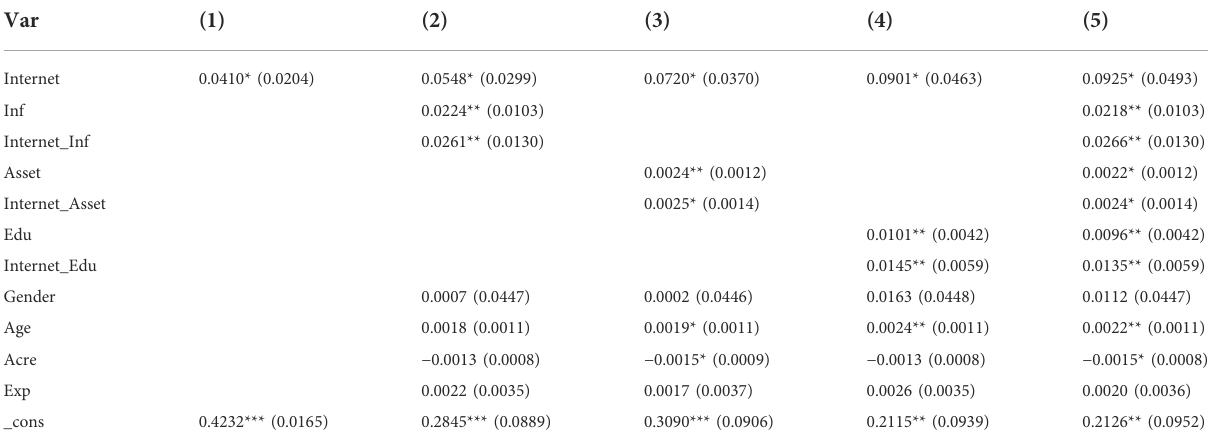
TABLE 2 Analysis of in fl uencing mechanism of the Internet on agricultural green production ef fi ciency.